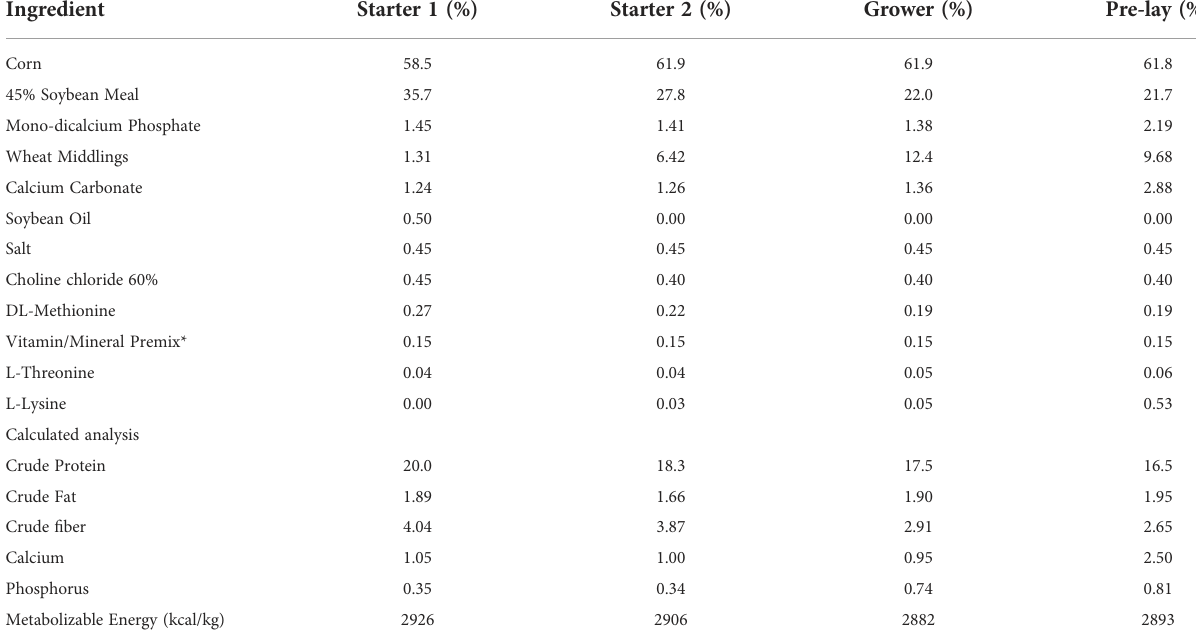
TABLE 2 Ingredient percentage and calculated nutrient analysis of 4 basal diets used in this